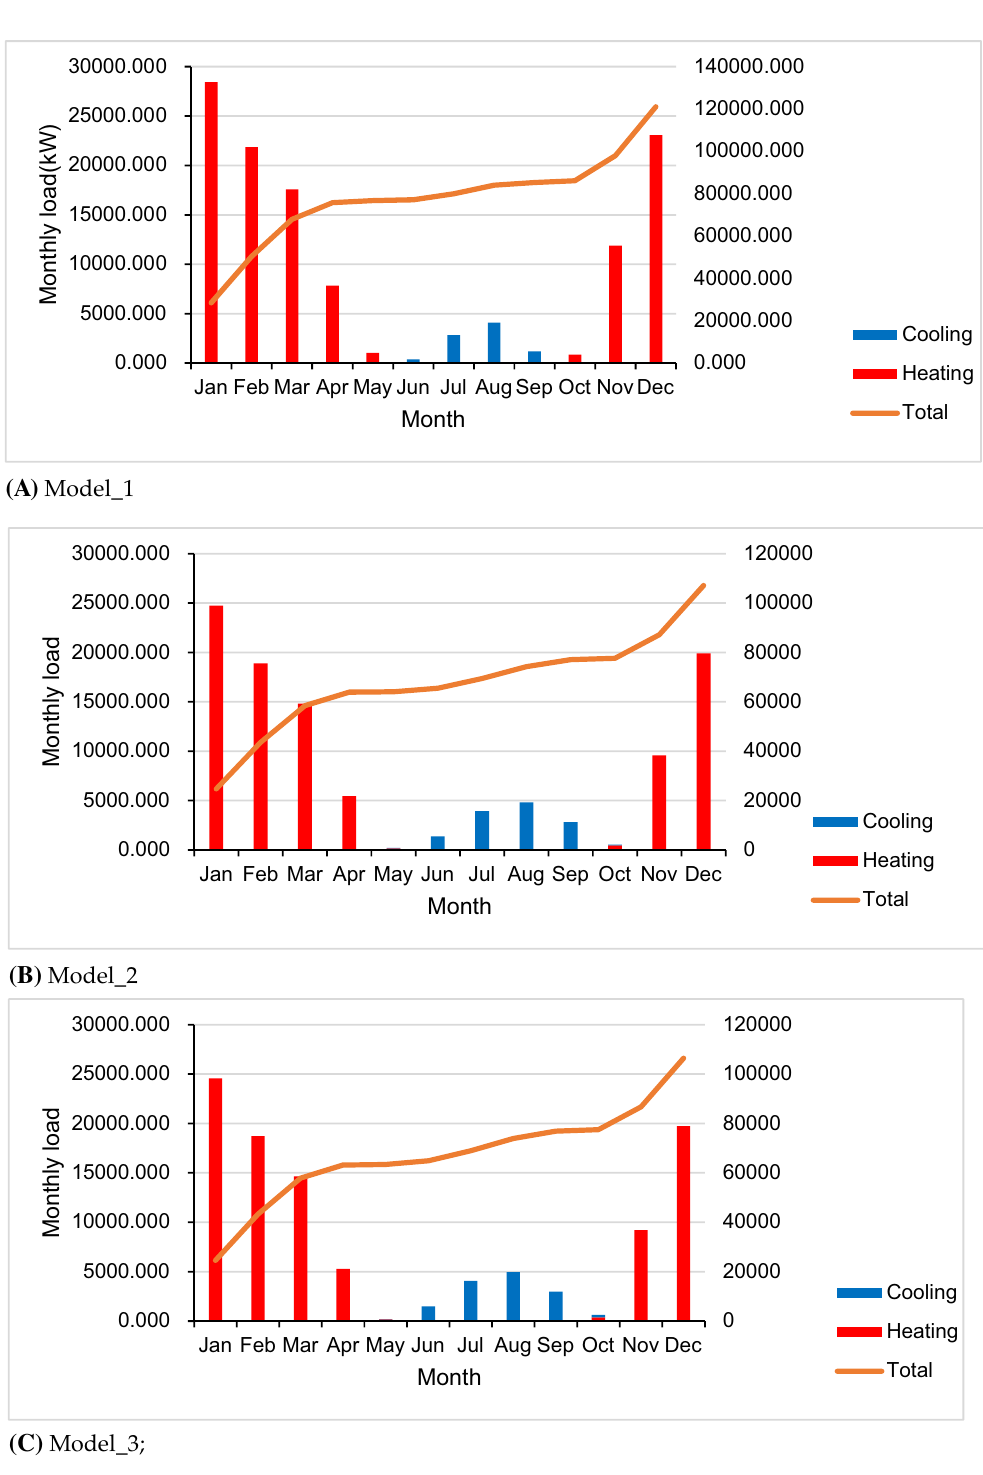
Figure 8. Monthly energy load profile. ( A ) Model_1; ( B ) Model_2; ( C )